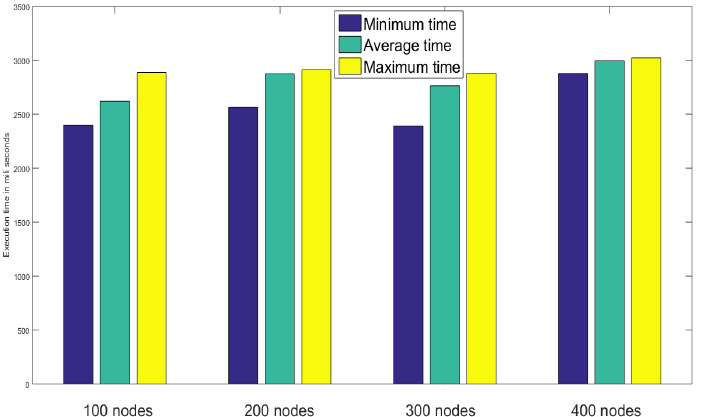
Figure 10. Performance analysis based on node creation and authentication time.